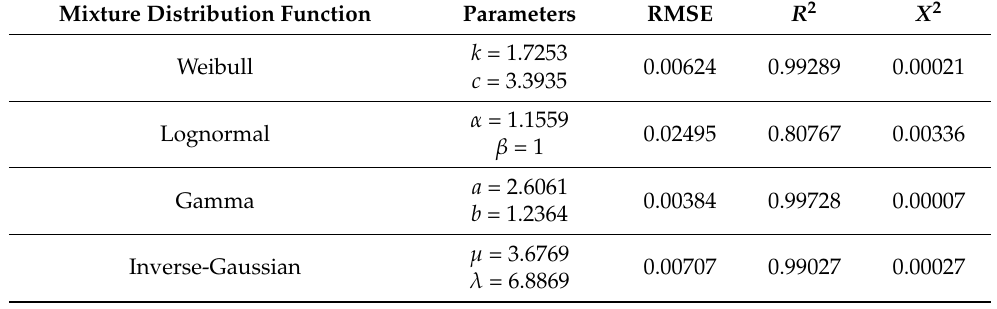
Table 1. The probability distribution parameters for original PDFs in wind speed modeling.